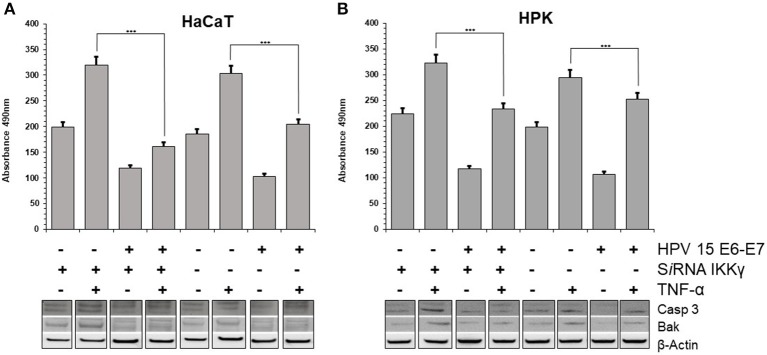
HPV15 affects TNF-α-induced apoptosis. HaCaT (A) and HPK (B) cells were utlized. HPV 15 transduction, IKKγ gene silencing and TNF-α treatment (10 ng/ml) for 6 h are indicated. Apoptosis was measured by a Cell Death ELISA test according to manufacturer's instruction in triplicate samples. Error bars = ±SD. ***p < 0.0001 by unpaired t-test. Activation of apoptotic pathway was analyzed in cell lysates by Western blots with anti-cleaved Caspase 3 or anti-BAK antibodies, as described in section Materials and Methods. All these experiments were repeated twice with similar results.